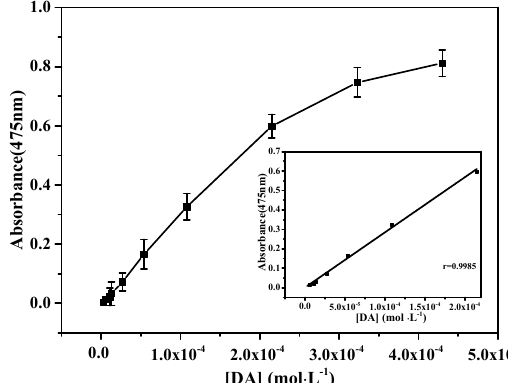
Figure 8. The linear range for colorimetric detection of DA with SiW 9 Co 3 . Insert: the plot of absorbance at 475 nm versus the concentration of DA. Experiments: 80 µL SiW 9 Co 3 , 60 µL H 2 O 2 , and reaction time of 10 min.